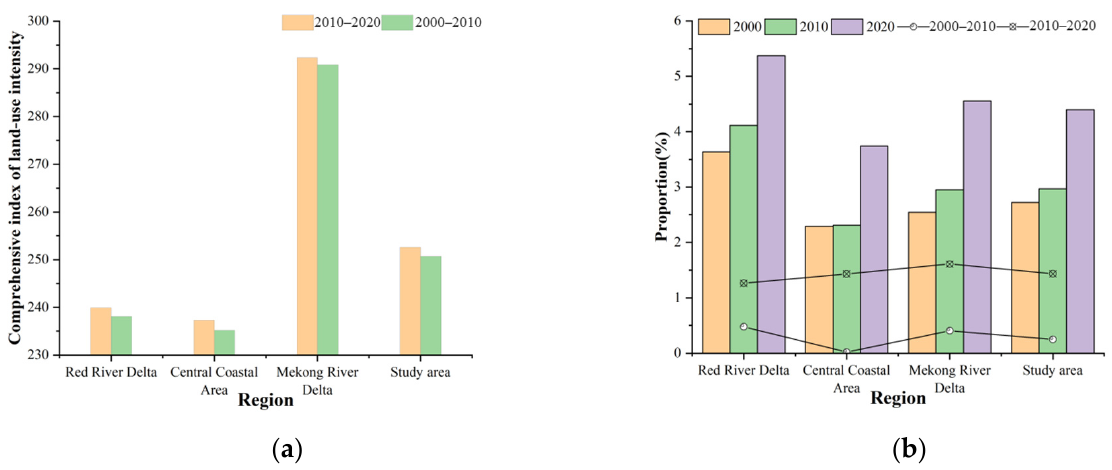
Figure 5. The development intensity of subregions ( a ) and changes in the proportion of construction land to the total area ( b ).